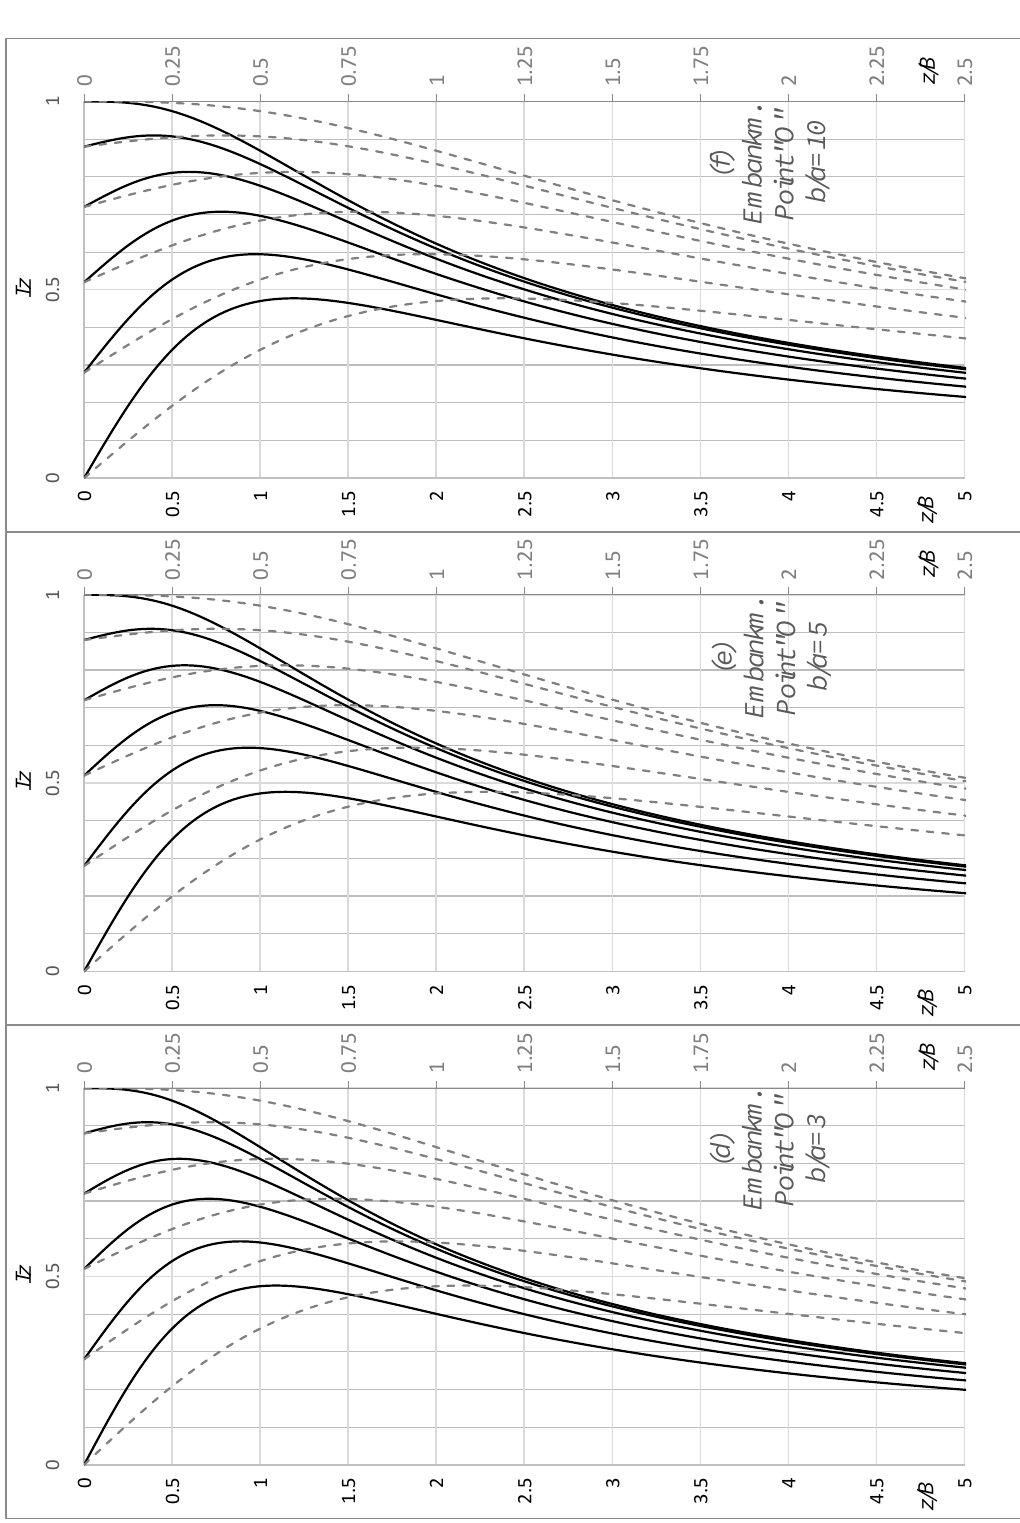
Figure 5. I z versus normalized depth charts referring to point “O” of the symmetrical embankment loading of Figure 8a for various ν values; ν ranges from 0.5 to 0 (left to right) with 0.1 interval.